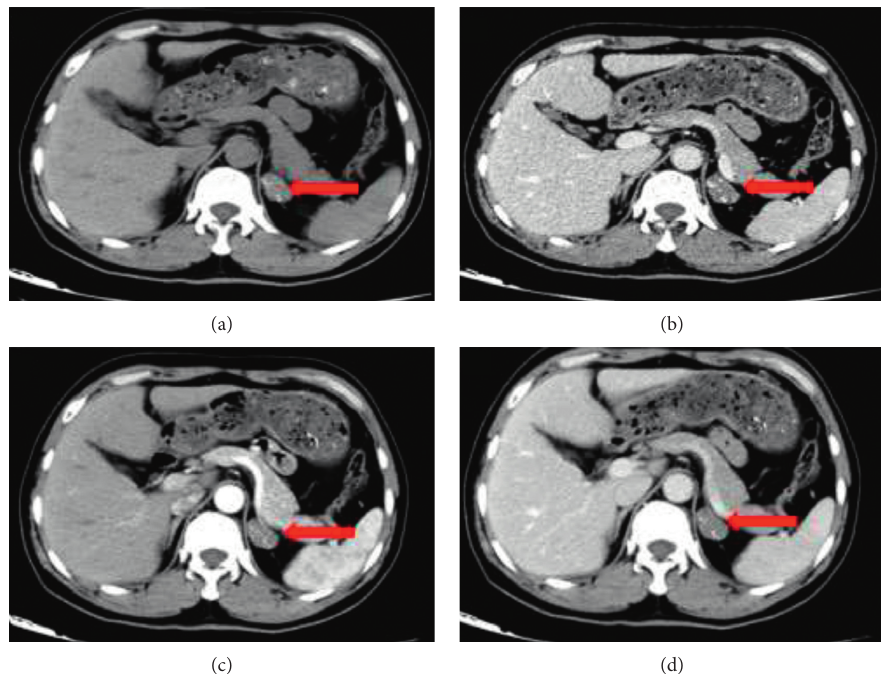
Figure 1: Left adrenal cavernous hemangioma with a tumor size of 2cm. CTimaging showing an oval, well-defined, obvious calcified mass with mild enhancement (red arrow) in the left adrenal region. (a) CT unenhanced. (b) Arterial phase of CT. (c) Venous phase of CT. (d) Delayed phase of CT.